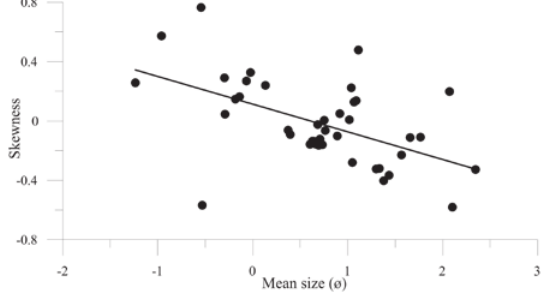
Figure 12 - Plotting of the mean size and skewness.